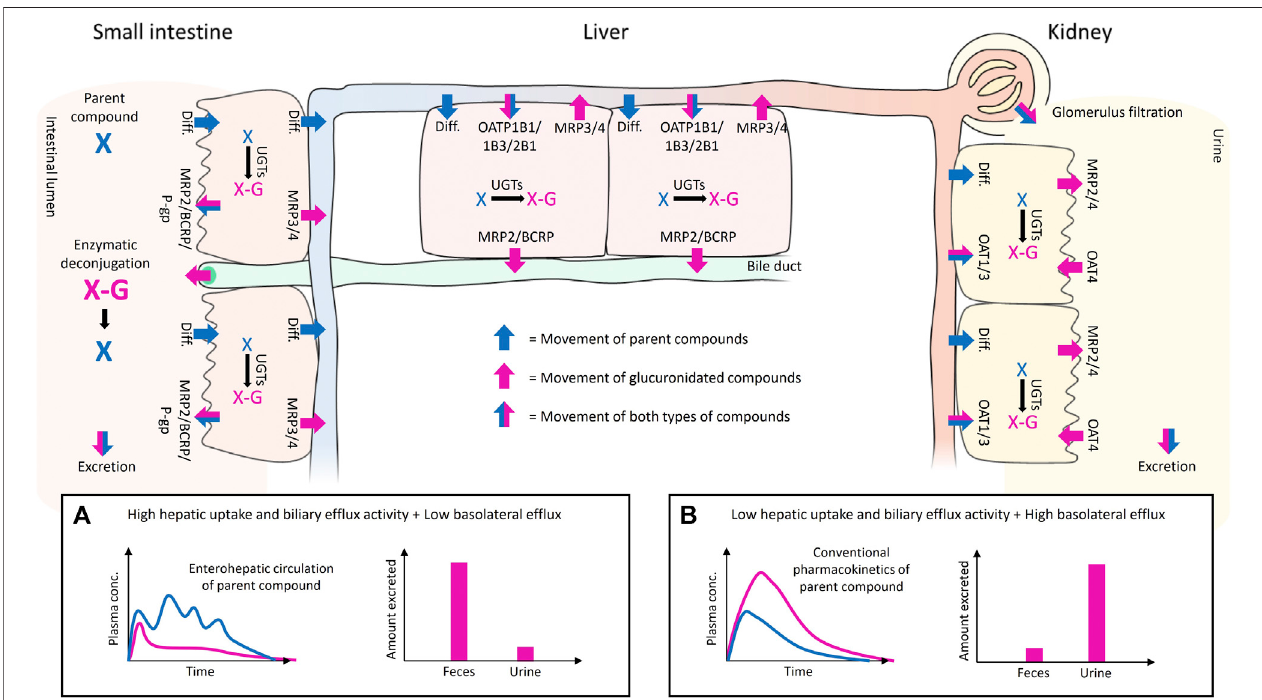
FIGURE 2 | Illustration of the interplay of uptake and ef fl ux transporters in the small intestine, liver, and kidney after oral administration of a parent compound that undergoes glucuronidation. The movement of the parent and its glucuronide conjugate are shown with blue and pink arrows, respectively. The movement of both compounds isshown withhalf-blue/half-pink arrows. The UGT-mediated glucuronidationoftheparentand theenzymatic deconjugationofglucuronidated compounds by bacterial β -D-glucuronidases in the gut are indicated with black arrows. The passive diffusion of compounds over membranes is abbreviated as Diff., and the transportersmentionedintheillustrationareconsideredtobethemostrelevanttransportersforglucuronidedispositioninthatparticulartissue.Examplesofuptakeand ef fl ux transporter interplay on the disposition ofthe parent and its glucuronide conjugate are presented in subpanels (A,B) . High hepatic uptake and biliary ef fl ux activity, and low hepatic basolateral ef fl ux (A) leads to enterohepatic recycling of parent compound (blue line) and favors the fecal excretion of glucuronide conjugate (pink bar). Low hepatic uptake and biliaryef fl uxactivity, andhigh basolateral ef fl ux (B) leadstoelevated plasmaconcentrationand renalexcretion oftheglucuronidatedcompound (pink line and